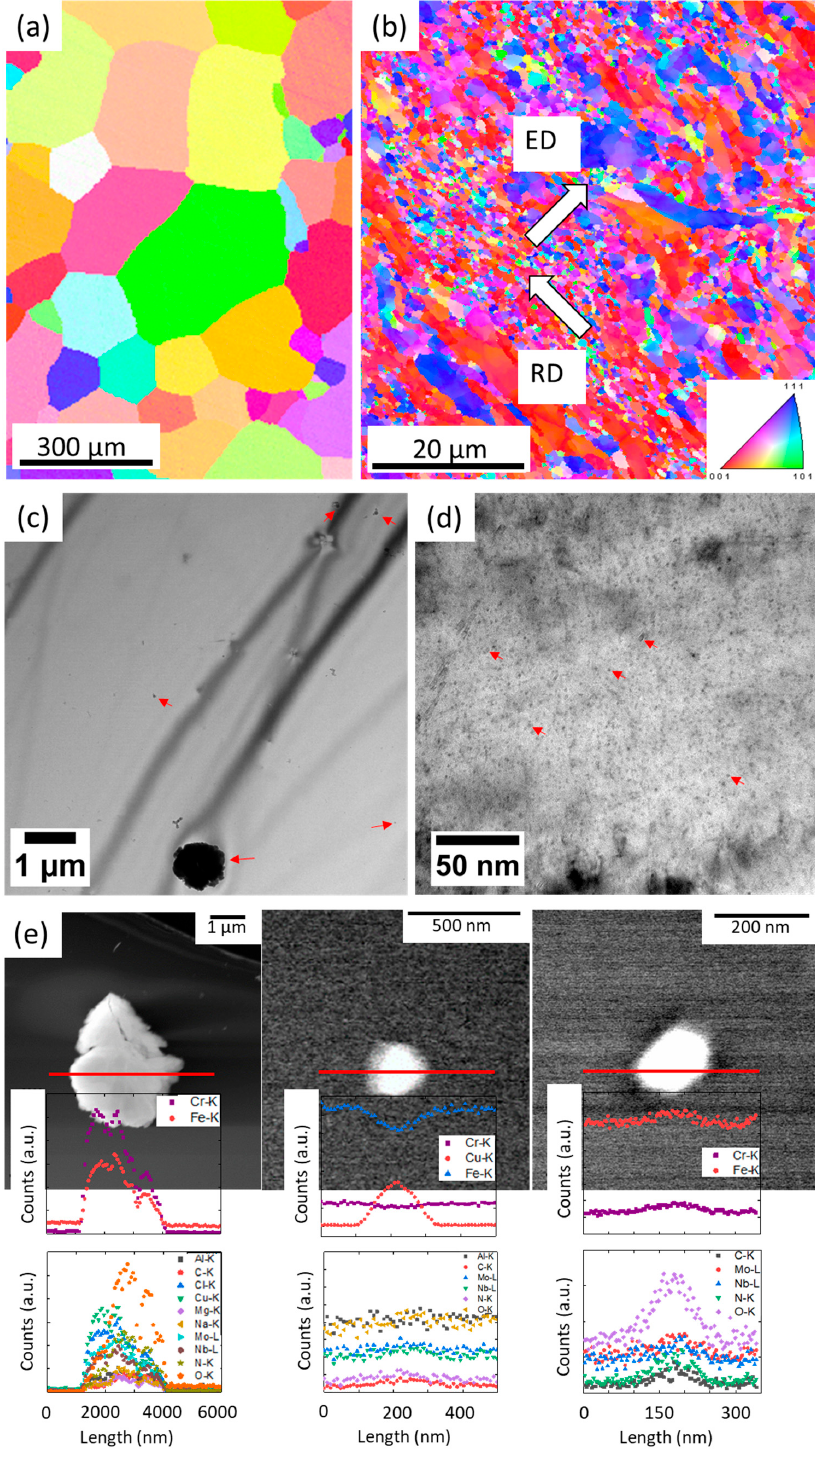
Figure 1. Orientation mapping of ( a ) FeCrAl and ( b ) 14YWT alloys; BFTEM micrographs of ( c ) FeCrAl and ( d ) 14YWT alloys, ( e ) EDX line scans along three different particles in FeCrAl alloy. White arrows in ( b ) indicate the extrusion and rolling directions of the 14YWT alloys. Red arrows in ( c ) and ( d ) indicate the second phase particles and NOs, respectively.